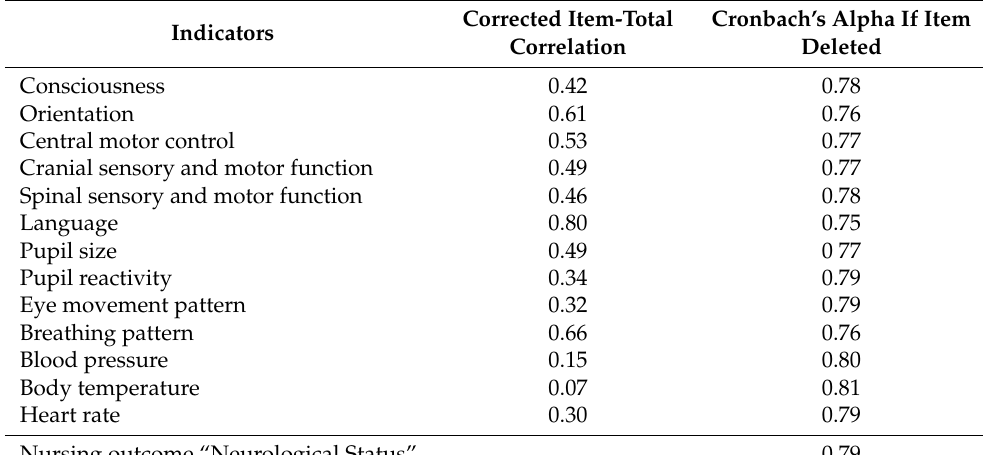
Table 4. Internal consistency (Cronbach’s alpha nursing outcome “Neurological Status” for patients with cerebrovascular